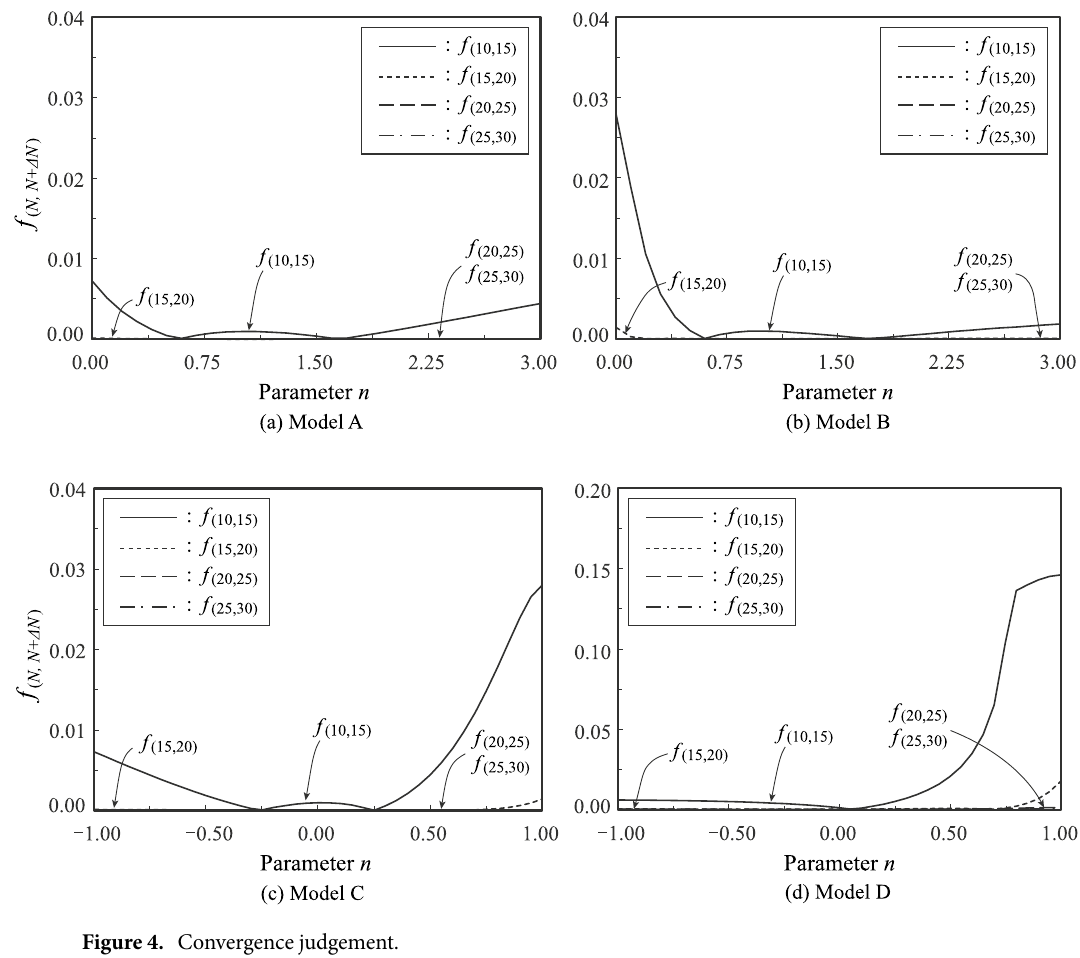
Figure 4. Convergence